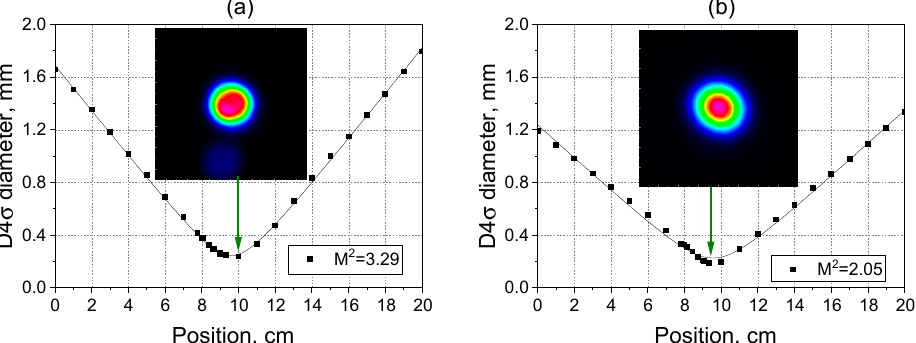
Figure 12. Measured quality parameter M 2 of the 1st Stokes (1018 nm) ( a ) and the 2nd Stokes (1064 nm) ( b ) beams at 40 W pump power. Insets: corresponding intensity profiles near the beam waist.